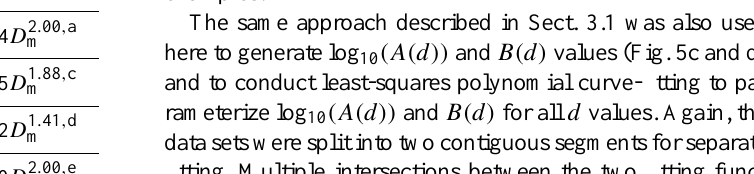
Table 7. Snow particle shapes considered in this study and their mass ( m ) and cross-sectional area ( A ) formulas. Snow particle Mass Cross-sectional area